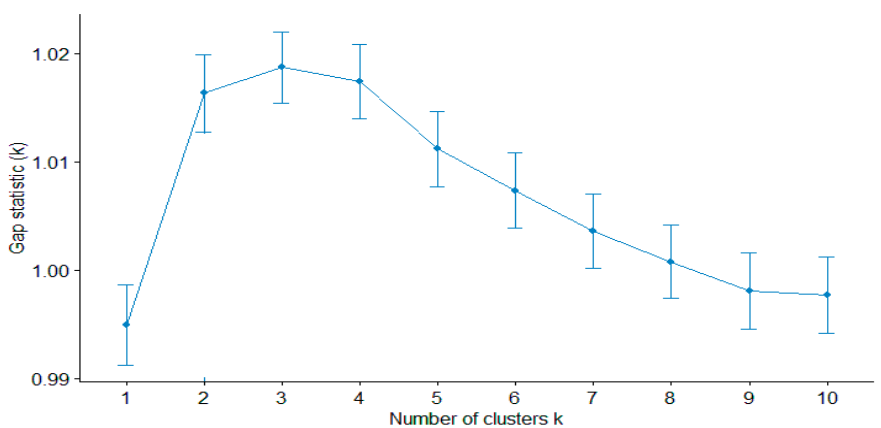
Figure 2. GAP statistics graph for selecting the optimal number of clusters.